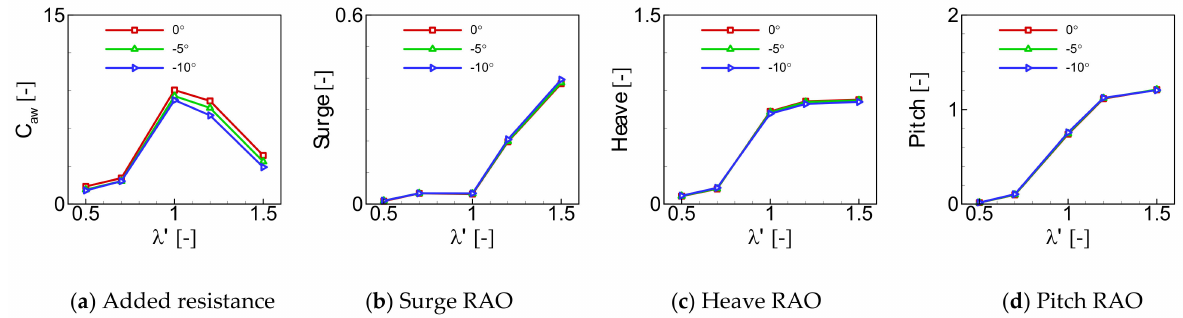
Figure 10. Computed added resistance and RAOs of surge, heave and pitch for different β 0 in head